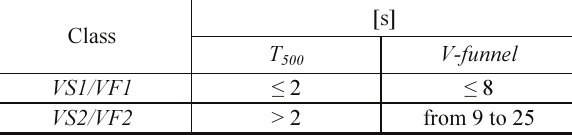
Table 2. Viscosity classes (European Project Group